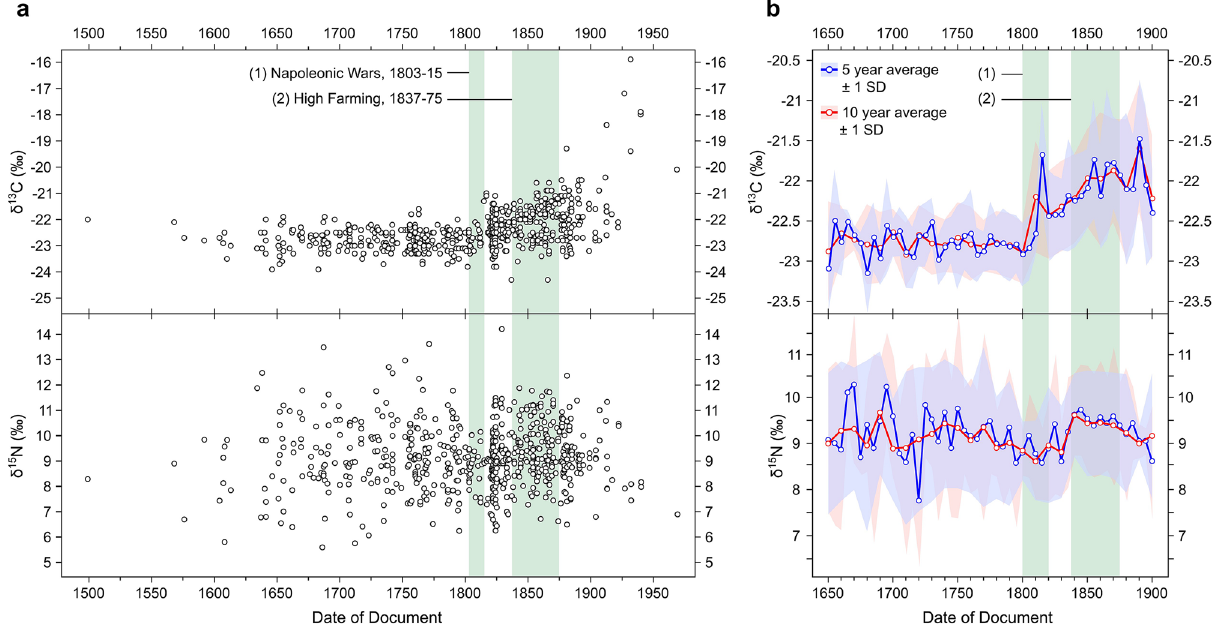
Figure 2. Isotope values from historic sheepskin parchment. ( a ) δ 13 C (top) and δ 15 N (bottom) of individual skins plotted against the year the document was signed; ( b ) 5 and 10-year averages of δ 13 C (top) and δ 15 N (bottom) from AD 1650 to AD